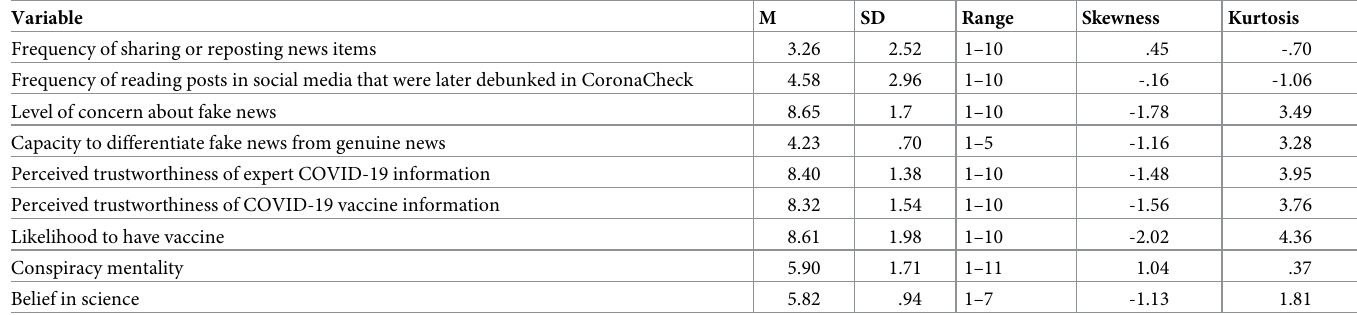
Table 4. Summary data for study variables.